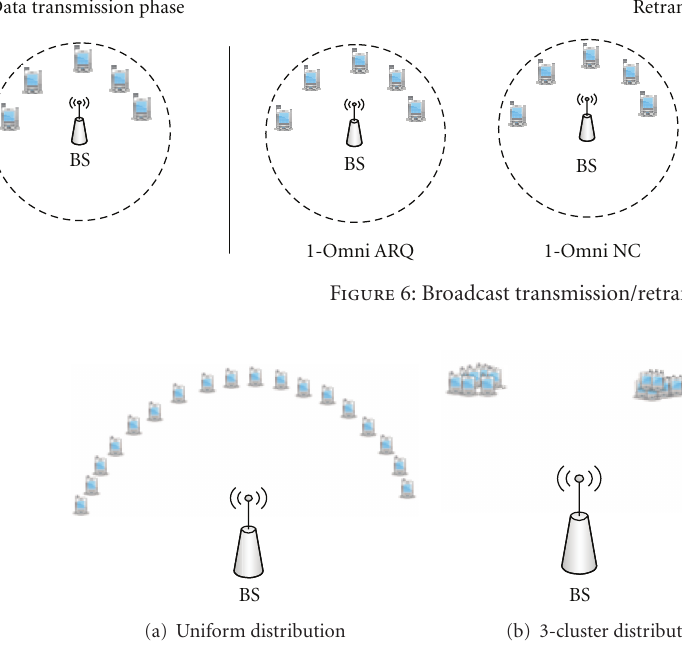
Figure 7: Simulated network topology scenarios with di ff erent MS